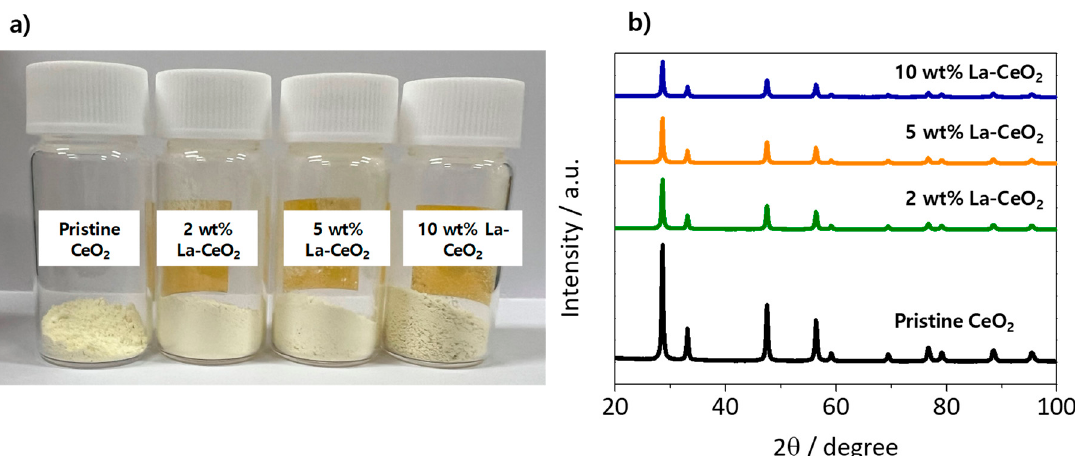
Figure 1. ( a ) photographs of the pristine CeO 2 and La-doped CeO 2 NPs at different La loading amount, ( b ) XRD pattern of the pristine CeO 2 and the La-doped CeO 2 NPs. Table 1. Cubic lattice parameter and BET surface area of the pristine CeO 2 and the La-doped CeO 2 NPs.